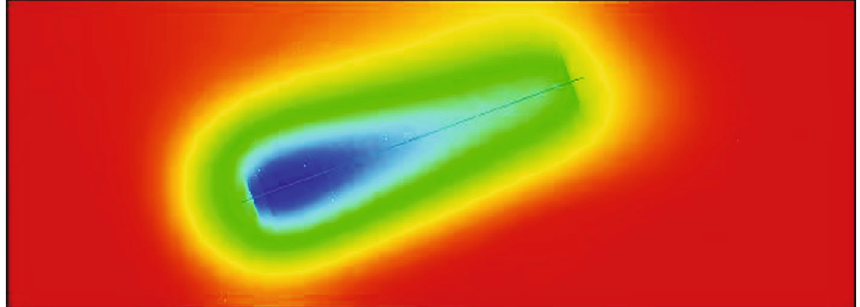
Figure 11: Gas saturation distribution of 1 day well shut-in.